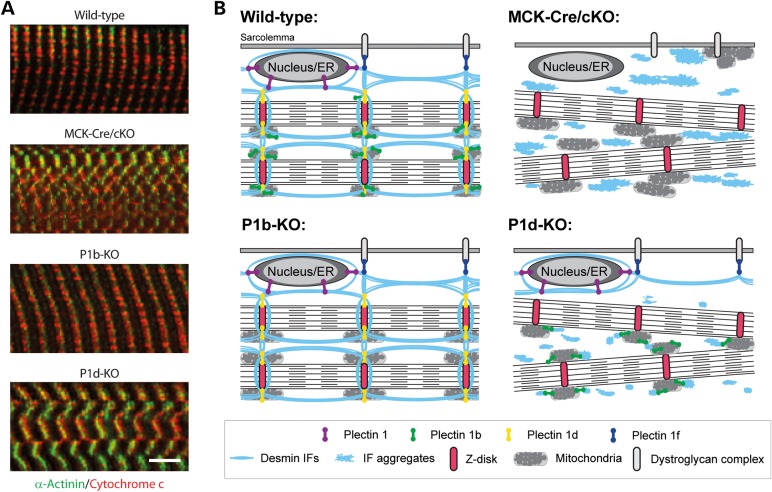
Spatial arrangement of mitochondria in skeletal muscle fibers and working models for phenotypic distinctions between P1b-KO and P1d-KO myofibers. (A) Teased EDL muscle fibers derived from wild-type, MCK-Cre/cKO, P1b-KO or P1d-KO mice were co-immunolabeled using antibodies to cytochrome c and the Z-disk marker α-actinin. Note that while mitochondria localize along the Z-disks in wild-type fibers, they are dispersed from Z-disks in MCK-Cre/cKO fibers. In P1b-KO fibers, reduced alignment of mitochondria with Z-disks was observed. In P1d-KO fibers, contrary to MCK-Cre/cKO fibers, mitochondria were still associated with the Z-disks. Scale bar: 5 µm. (B) Schemes of working models. Phenotypic distinctions are based on this and previous studies (8,9,11,14). In wild-type skeletal muscle, distinct isoforms of plectin bind to desmin IFs and interlink myofibrils with each other at the level of Z-disks (P1d), with the costameric lattice (P1f), with mitochondria (P1b) and with the outer nuclear/endoplasmic reticulum membrane system (P1). In plectin-deficient muscle (MCK-Cre/cKO), desmin IFs detach from Z-disks, costameres, mitochondria and nuclei, thereby causing progressive degenerative alterations including massive desmin aggregation, misalignment of Z-disks, and aggregation and elongation of mitochondria [see also (11,14)]. Loss of mitochondrion-associated P1b leads to elongation of mitochondria, whereas the myofibrillar apparatus remains in order, owing to other plectin isoforms still fulfilling their functions. Deficiency of Z-disk-associated P1d leads to misalignment of Z-disks and generation of small desmin aggregates throughout the sarcoplasm, whereas mitochondria display normal shape and are still associated with myofibrils. Note that the assignment of plectin isoforms to their normal locations in P1b-KO and P1d-KO muscles (schemes in lower row) is predictive but still hypothetical.